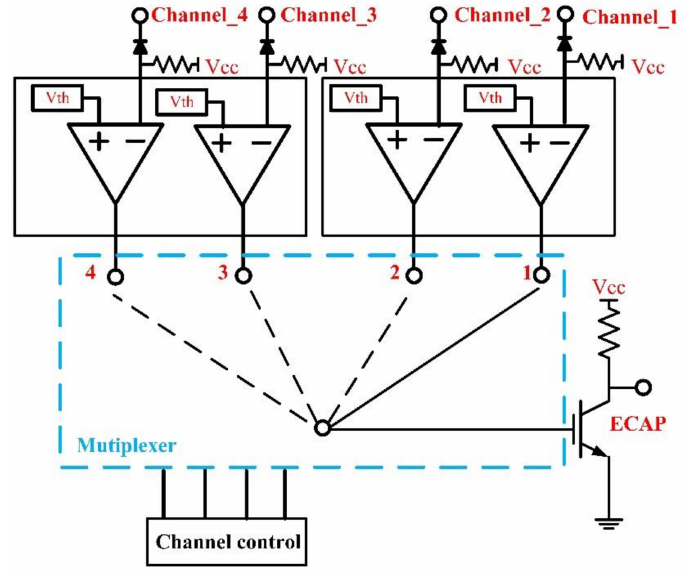
Figure 11. The proposed multiplexer